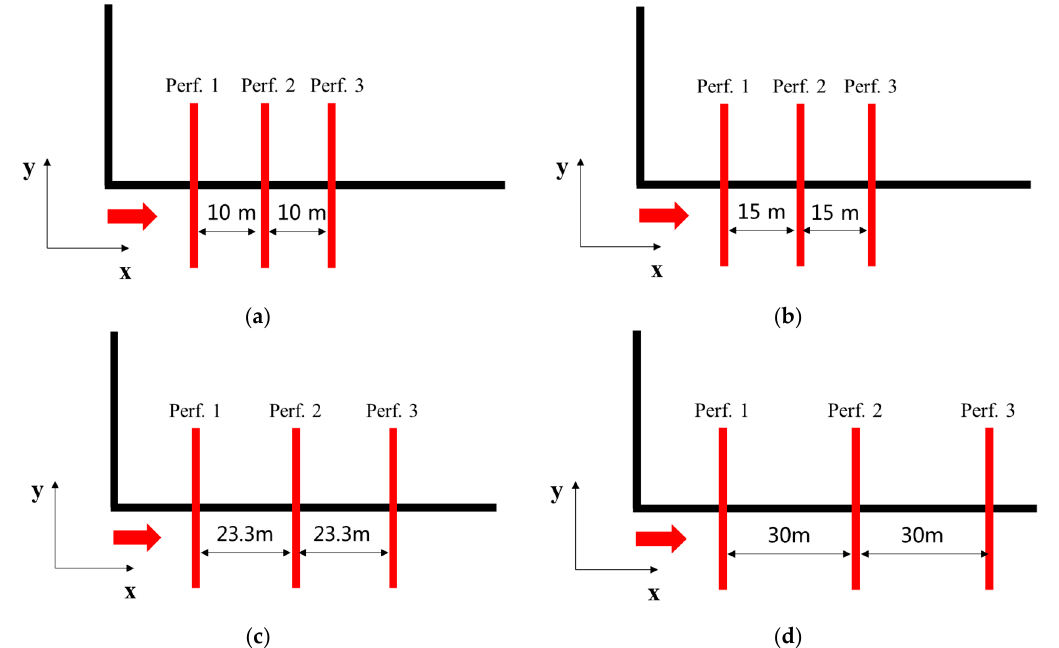
Figure 4. Different fracture spacings in a single stage: ( a ) 10 m; ( b ) 15 m; ( c ) 23.3 m; and ( d ) 30 m.